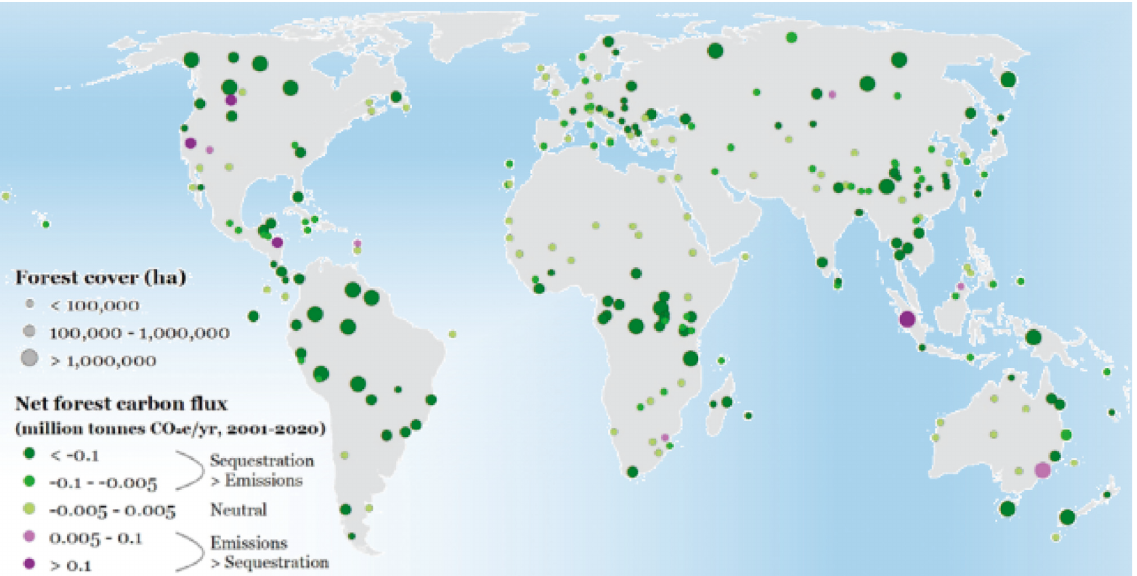
Figure 1: Net carbon flows from natural and mixed forests published by